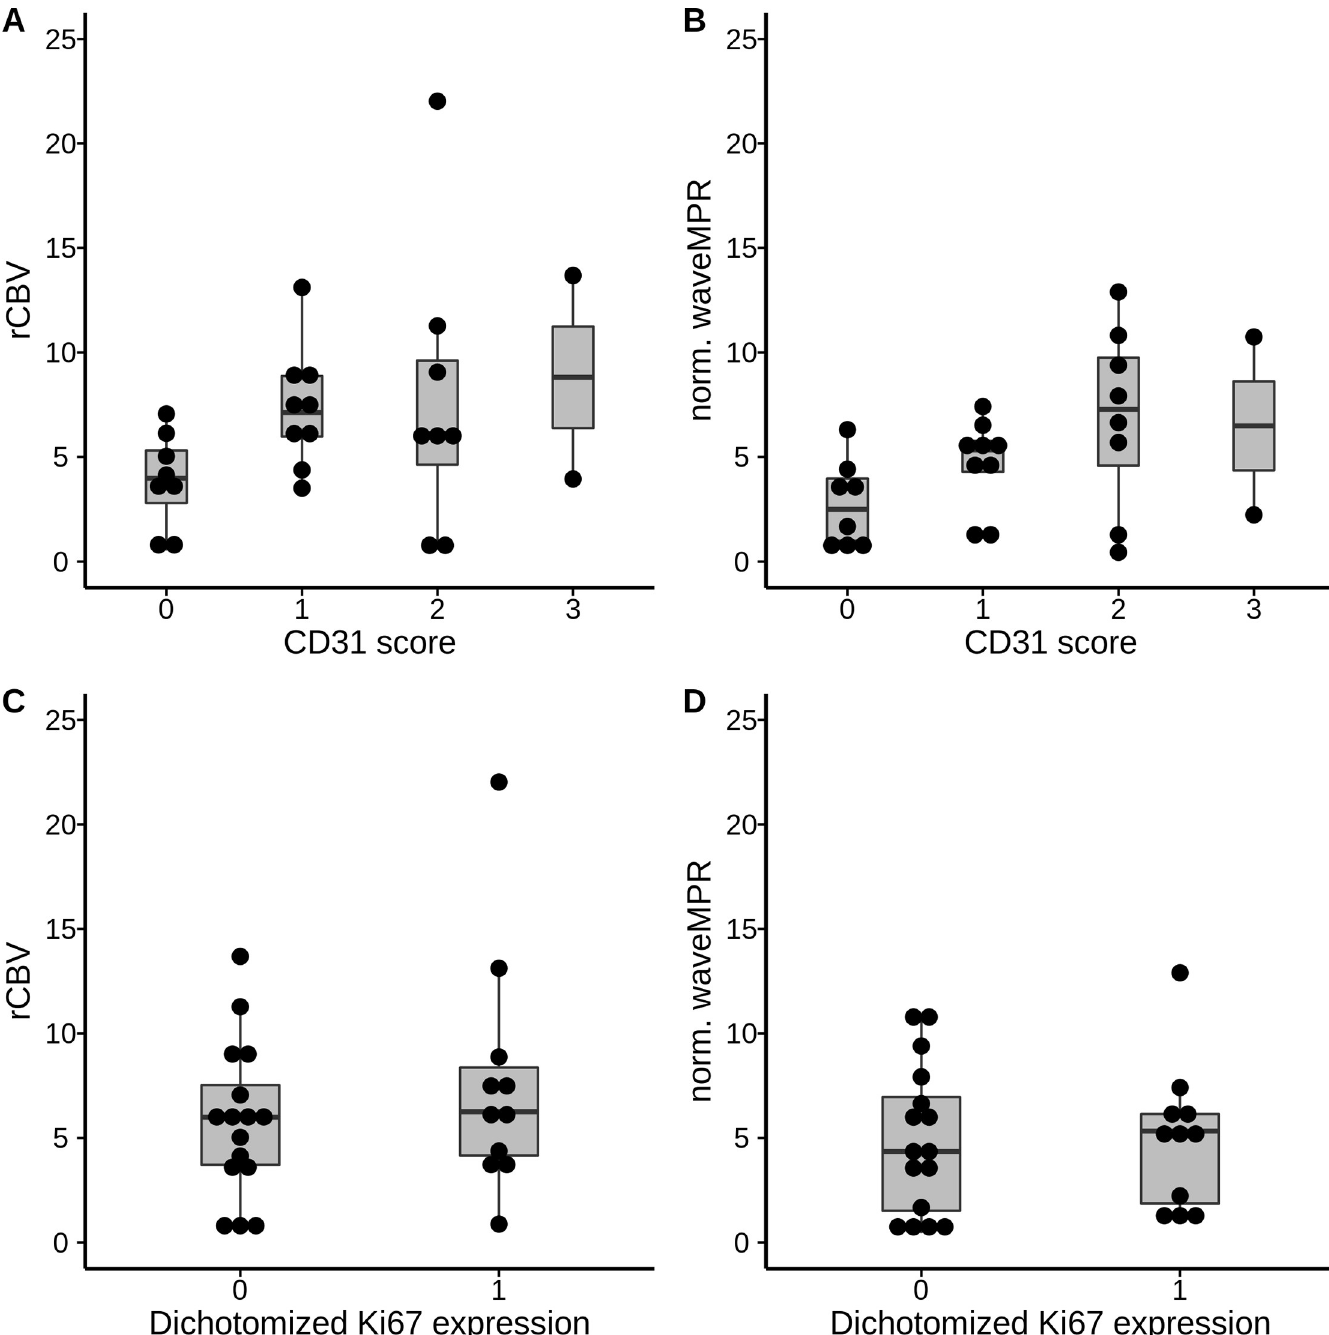
Fig 5. Box plots of normalized CBV (A) and normalized wavelet-MRP (B) in relation to the CD31 score as well as normalized CBV (C) and normalized wavelet-MRP (D) in relation to dichotomized